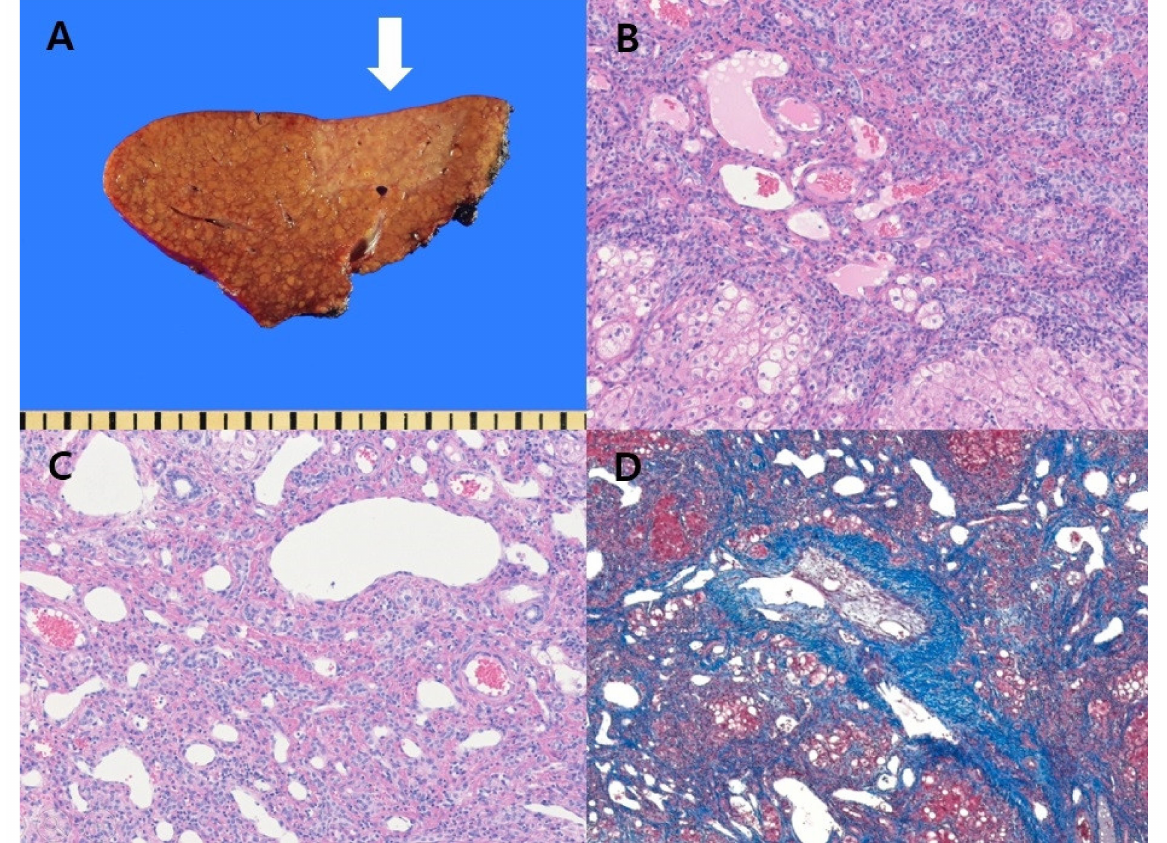
Figure 2. ( A ) Gross finding of the tumor. Grossly, an approximately 3-cm-sized, bright yellow mass-like lesion revealing ill-defined margins in the cirrhotic liver (white arrow); ( B , C ) Microscopic findings reveal focal loss of hepatocytes with increased capillary-sized vessel dilatation ( B , C : hematoxylin and eosin staining, × 40, × 100, respectively); ( D ) Abundant fibrous septa with dilated capillary vessels are seen. ( D : Trichrome staining × 40).